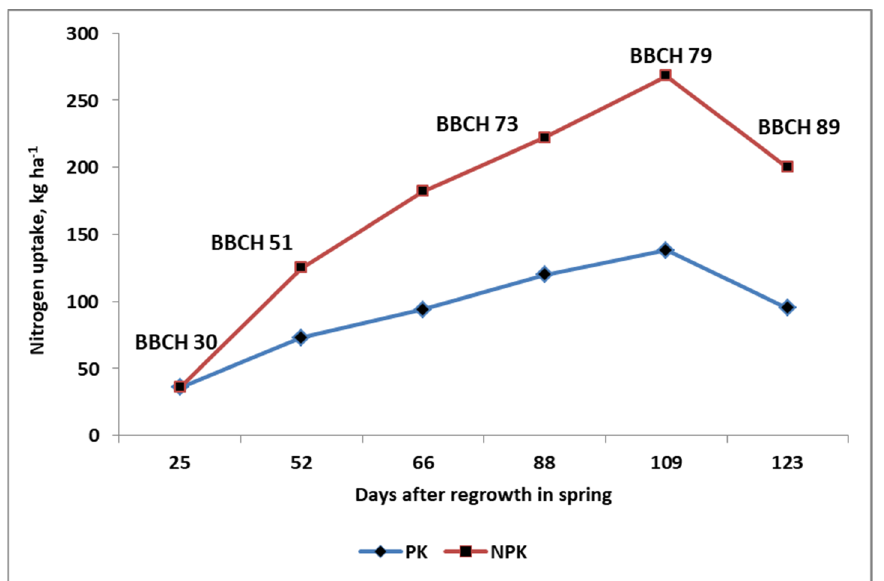
Figure 4. The nitrogen accumulation by winter oilseed rape during the spring vegetation depending on the N supply. Legend: BBCH 30—growth stages of plant in accordance to the BBCH scale [131] (own study based on